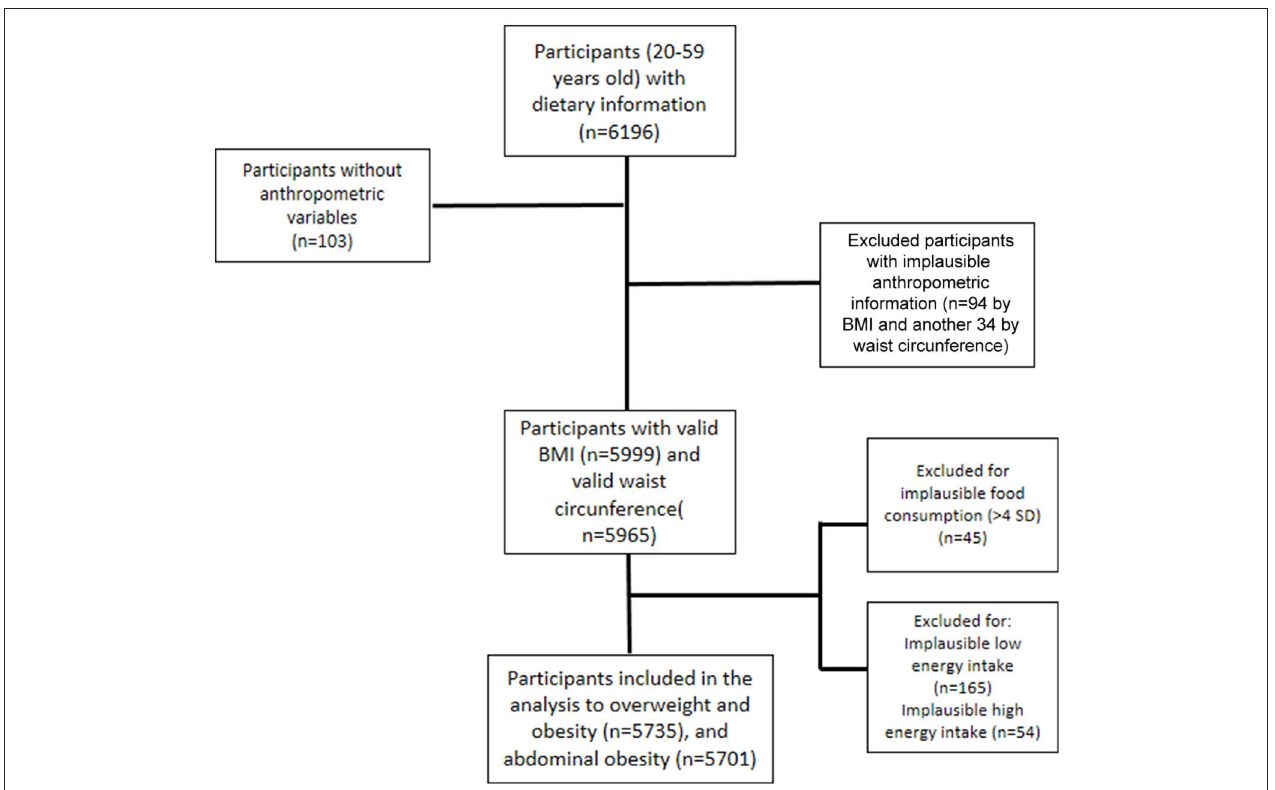
FIGURE 1 | Flow chart of sample size of Mexican adults, National Health and Nutrition Survey